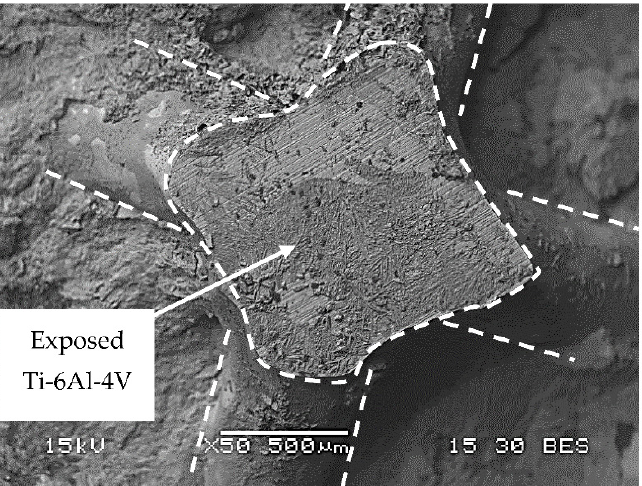
Figure 9. General appearance of corrosion attack obtained after 14 days of immersion test: ( a ) Zn– 2%Fe alloy and ( b ) OI–TiZn system.